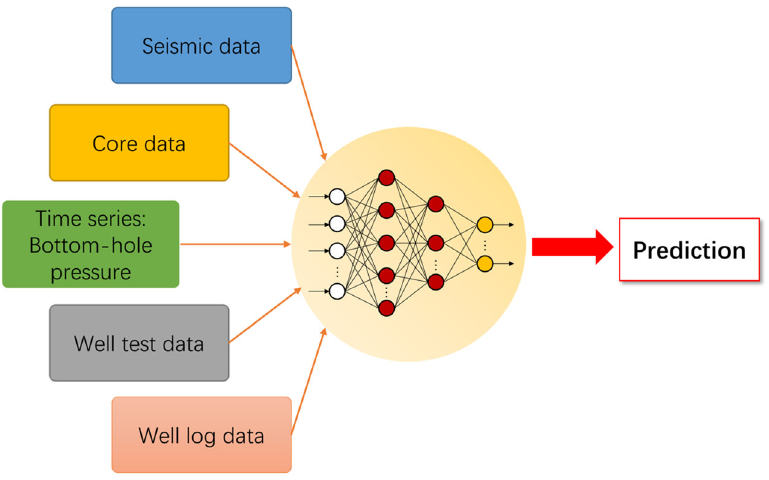
Figure 2. Illustration of integrating multiple data source.